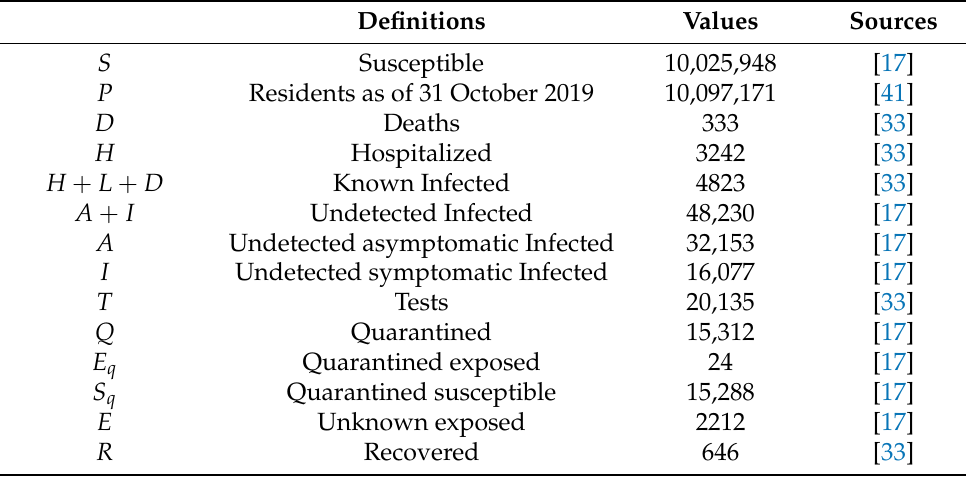
Table A1. Initial conditions for BSM on 9 March 2020.